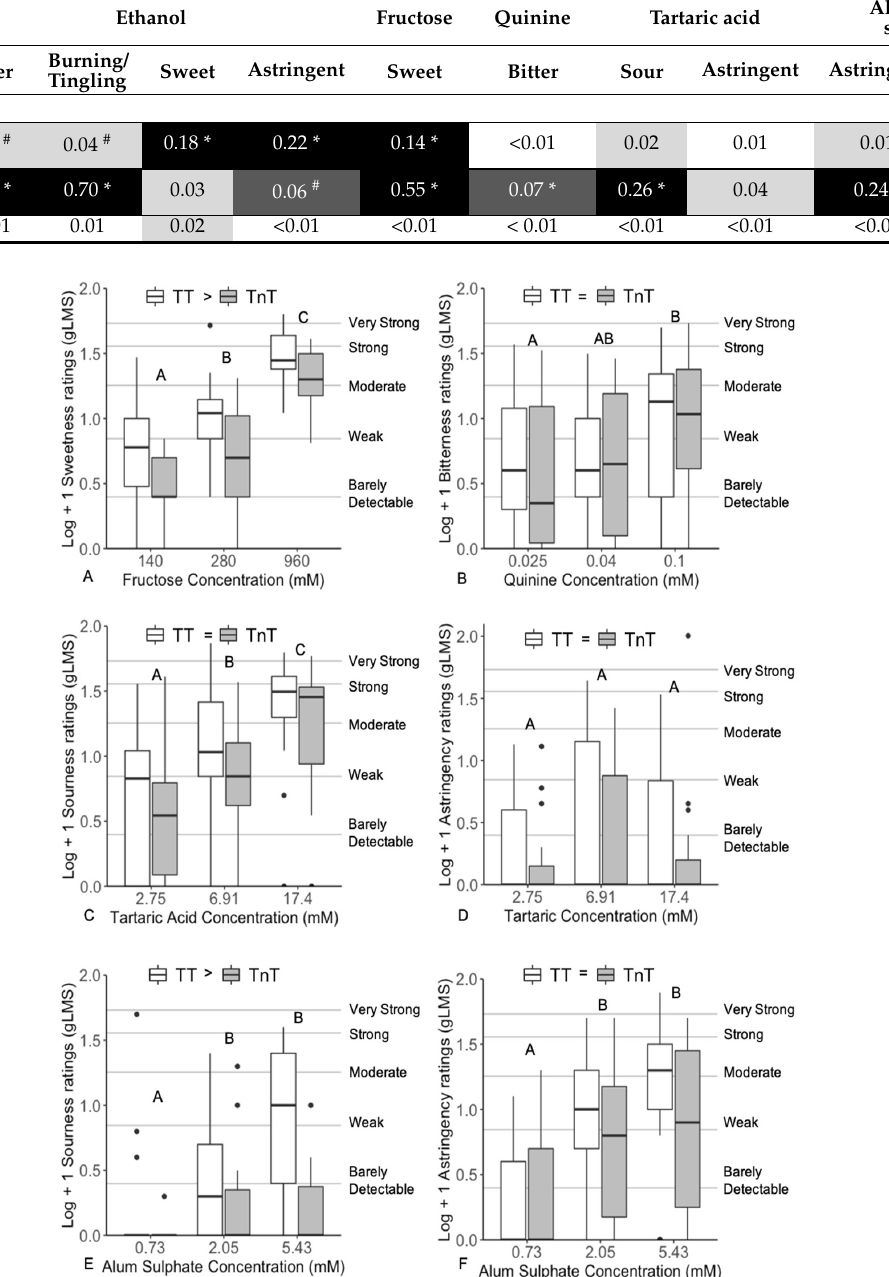
Figure 3. Unary solution boxplots of the mean sweetness of fructose ( A ), bitterness of quinine ( B ), sourness of tartaric acid ( C ), astringency of tartaric acid ( D ), sourness of aluminium sulphate ( E ) and astringency of aluminium sulphate ( F ) by concentration (low, medium, high) and thermal taste status (TT, TnT). Significant differences between mean concentrations are shown with different letters above the boxplots. Significant differences between thermal tasters (TT, n = 21–22) and thermal non-tasters (TnT, n = 13–15) are indicated by the mathematical symbols in the legend.